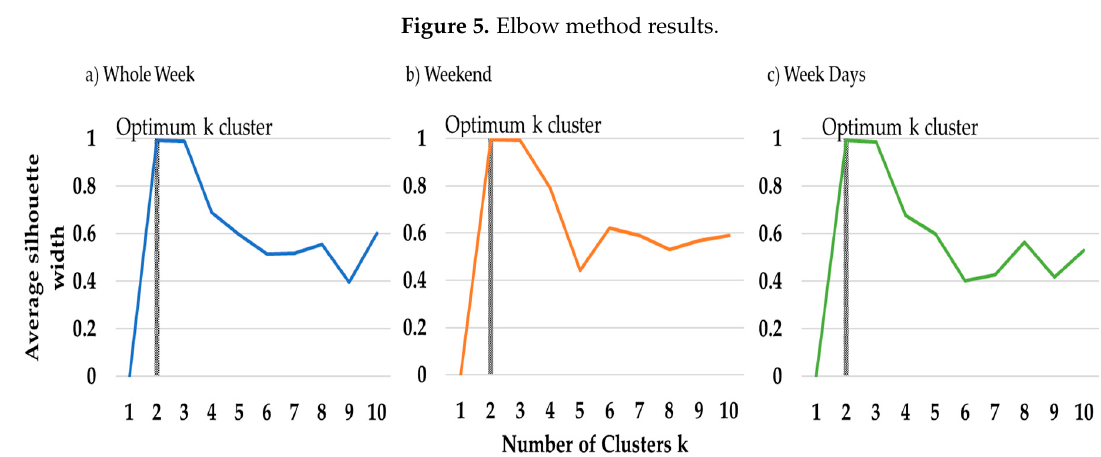
Figure 5. Elbow method results.